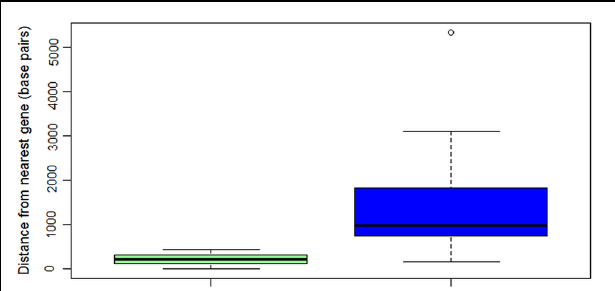
FIGURE 5 | Box and whisker plot showing distances in base pairs from nearest gene to core eukaryotic genes ( n = 439, green), or to ALVi genes ( n = 24, blue) in V. inaequalis Vi1.